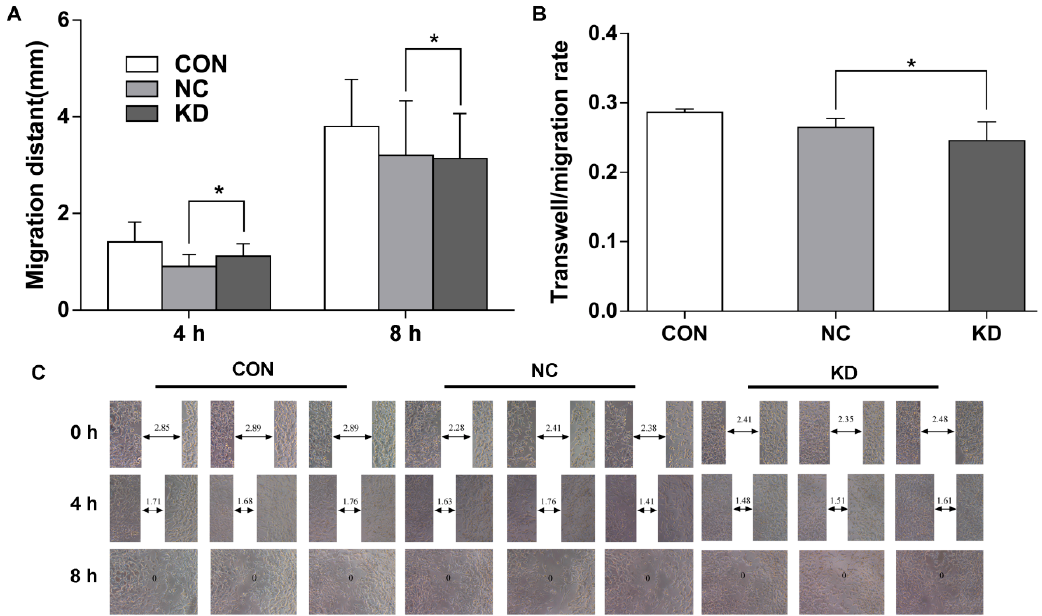
Figure 5. Suppression of EBLN1 expression does not affect the migration of OL cells. ( A ) Statistical analysis of the results of wound-scratch assays of OL cells in the 3 indicated groups; ( B , C ) effects of EBLN1 silencing on the transwell migration ability of OL cells, as determined in wound-healing assay. CON, uninfected group; NC, LV-NC-shRNA group; KD, LV-EBLN1-shRNA group. * p > 0.05.